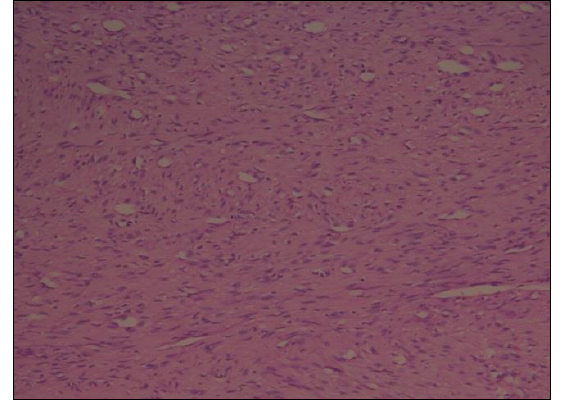
Figure 2: Histopathological picture revealing clear cells, spindle cells and fibrovascular